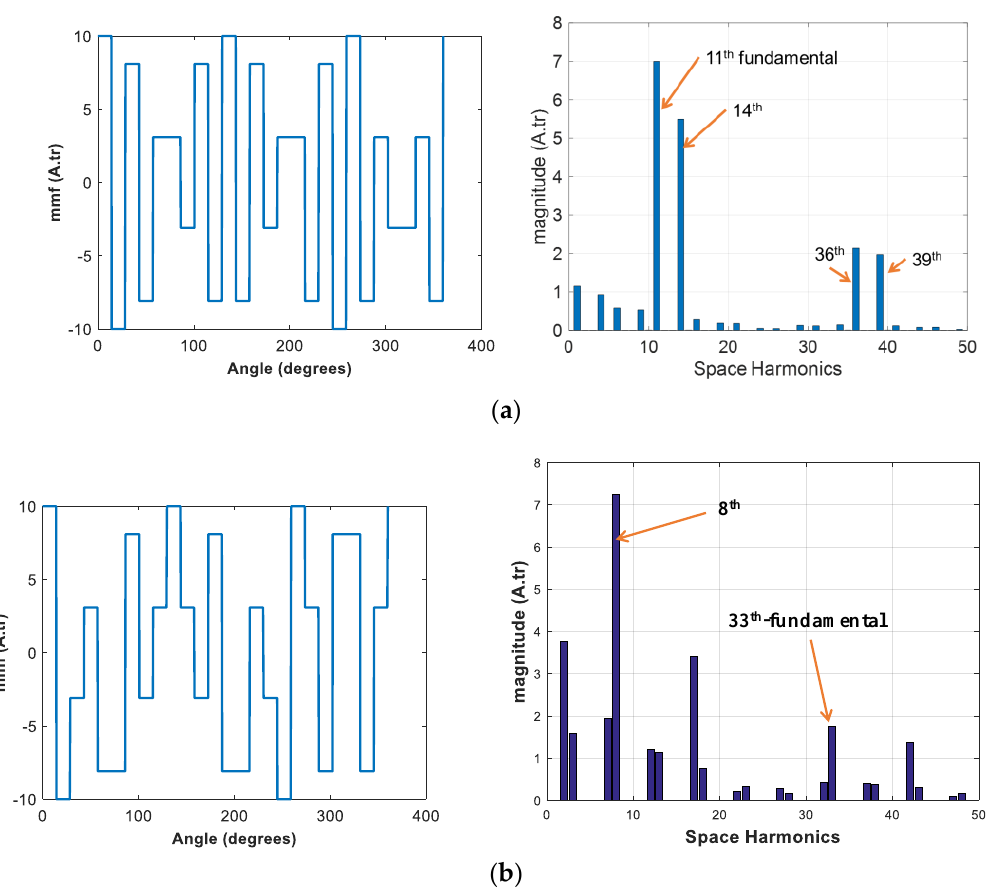
Figure 2. MMF harmonic spectrum of five-phase SPM with fundamental current and third harmonic current: ( a ) fundamental harmonic; ( b ) third harmonic.